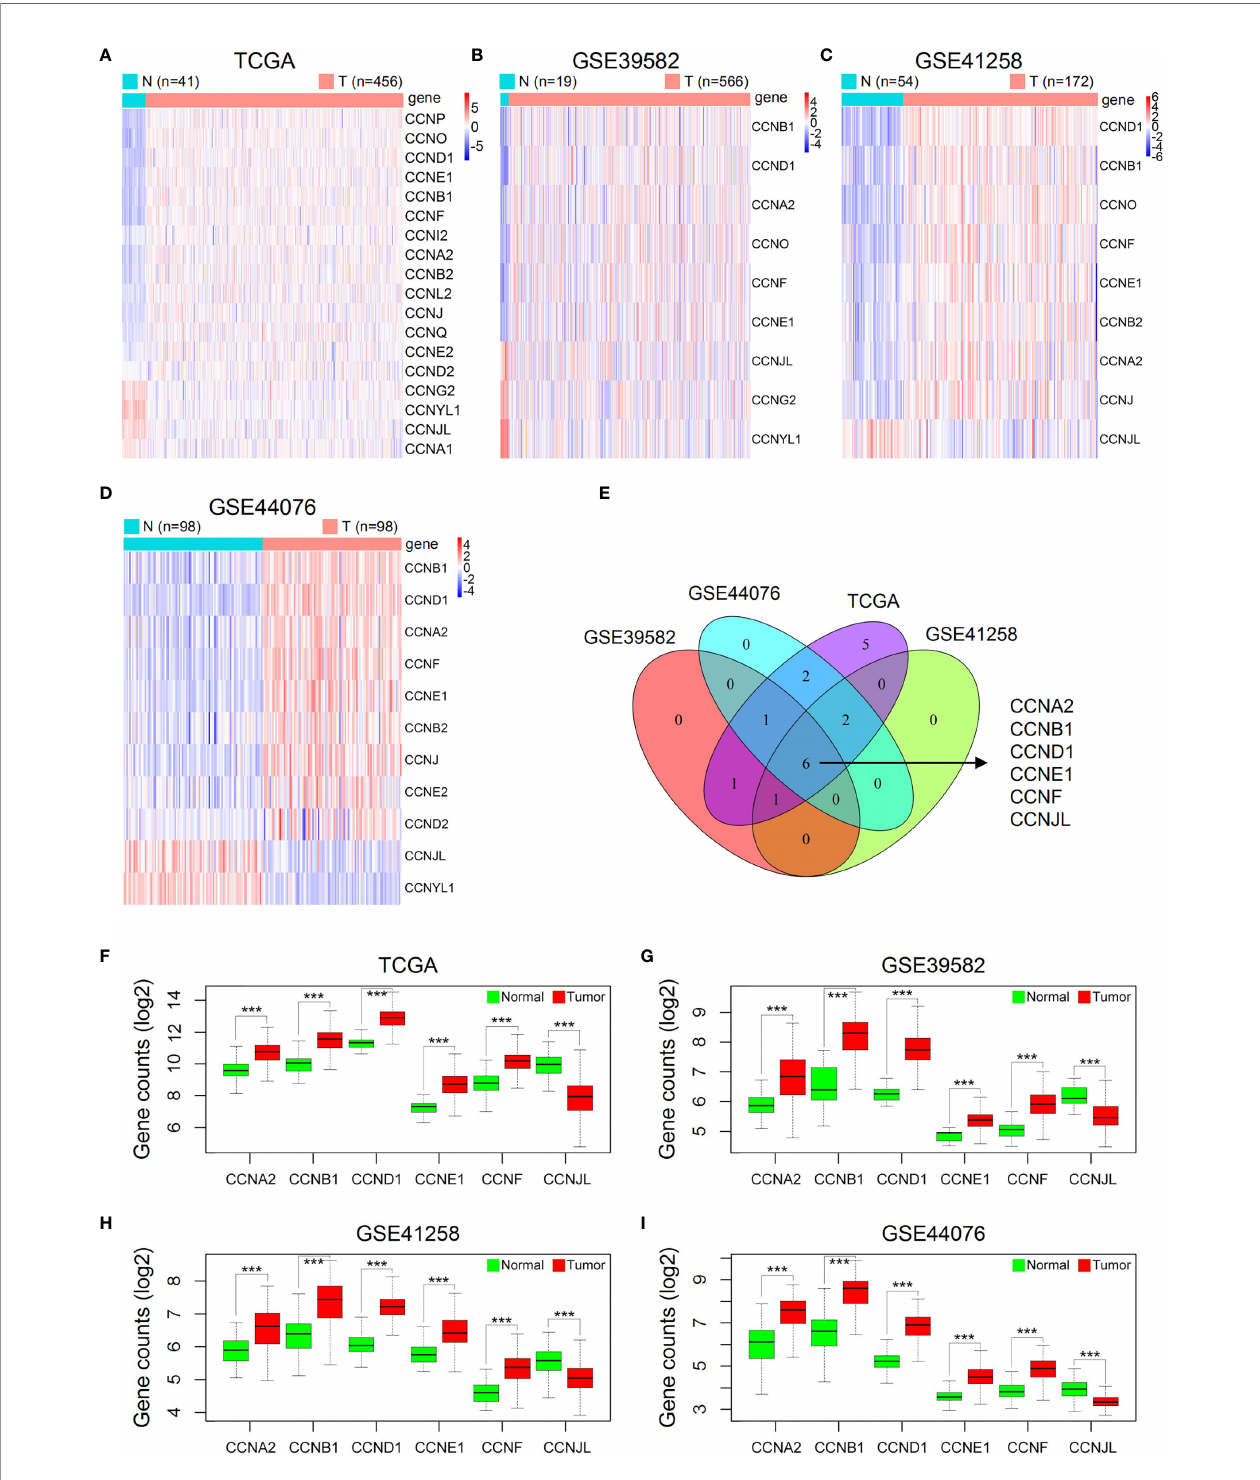
FIGURE 2 | Expression levels of cyclin family genes between normal and tumor samples of patients with colon cancer in the four datasets. (A – D) Heatmaps of the DEGs in the cyclin family. The red and blue colors represent high and low expression, respectively. N, normal; T, tumor. (E) The Venn diagram indicates six mutual DEGs among the four datasets. (F – I) Boxplots of the six DEGs further showed their expression difference between normal and tumor groups. ***P <